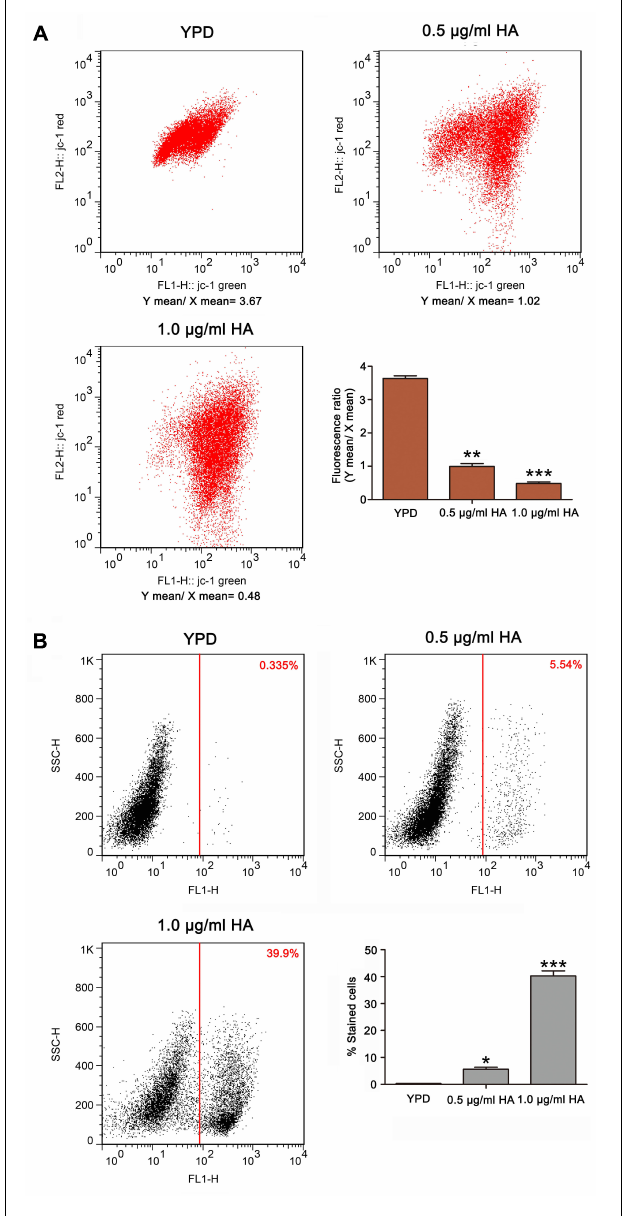
FIGURE 4 | Mitochondrial membrane potential and metacaspase activation were analyzed in HA-treated C. albicans cells. (A) The mitochondrial transmembrane potential was evaluated using JC-1 staining. The histogram was the quantitative data of fluorescence ratio ( Y mean/ X mean). ∗∗ P < 0.01 and ∗∗∗ P < 0.001. (B) Metacaspase activity was determined using CaspACE FITC-VAD-FMK in situ marker. The percentage of stained cells was presented in the histogram, and data were shown as mean ± SD ( n = 3) of three independent experiments. ∗ P < 0.05 and ∗∗∗ P <